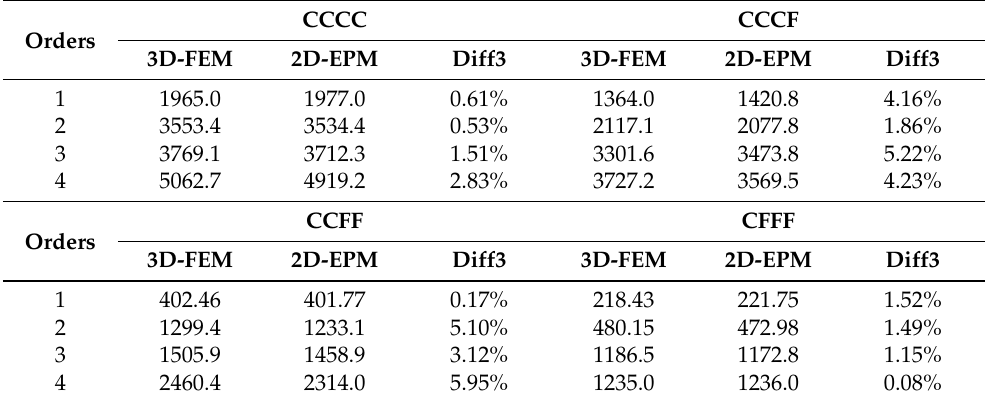
Table 5. Comparison of the first four natural frequencies (Hz) of the triangle HSP predicted by different